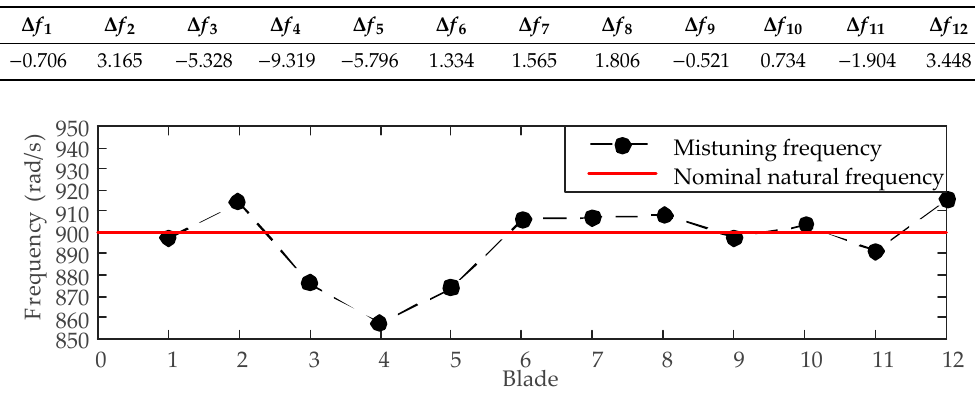
Figure 4. The mistuning frequency of the blade.